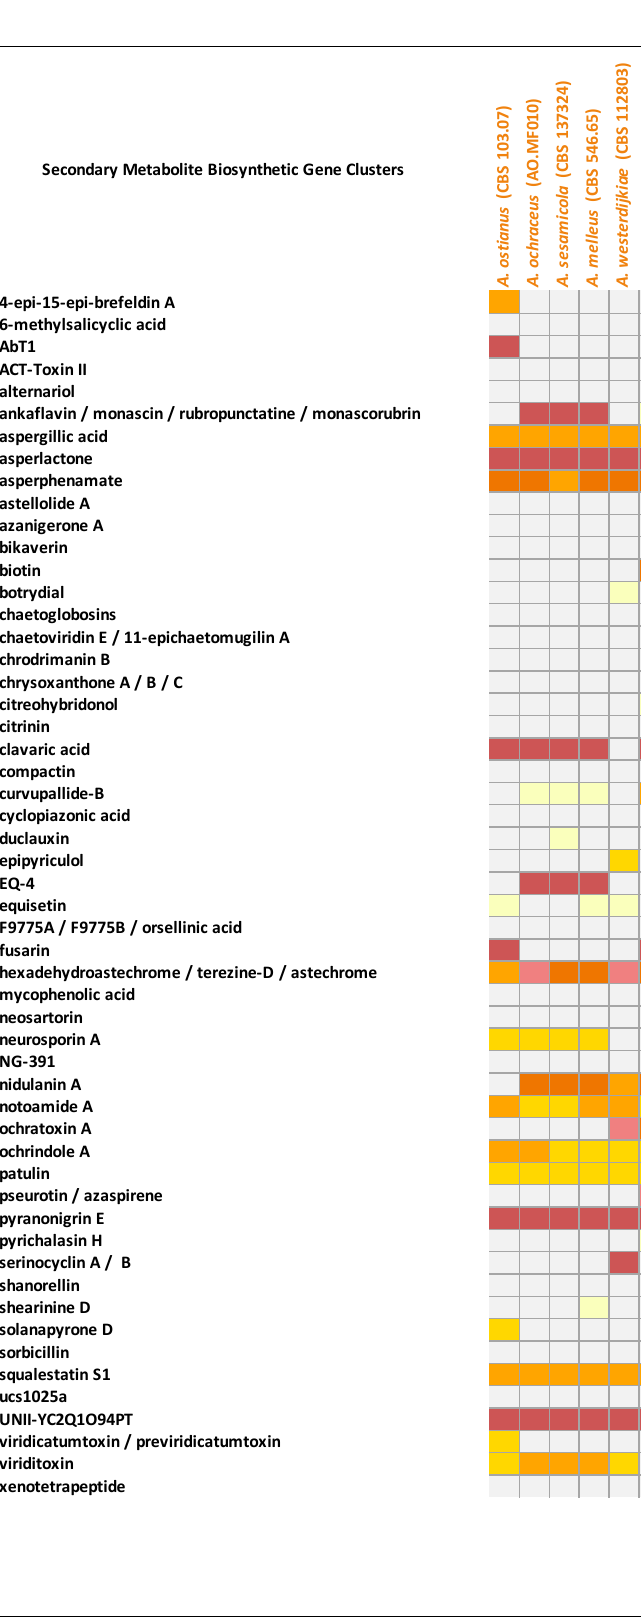
Figure 4. Matrix indicating the similarity of secondary metabolite gene clusters of Circumdati genomes (series Sclerotiorum in blue, series Steyniorum in pink, and series Circumdati in orange) in relation to known clusters from the antiSMASH. The color key is given as a percentage.